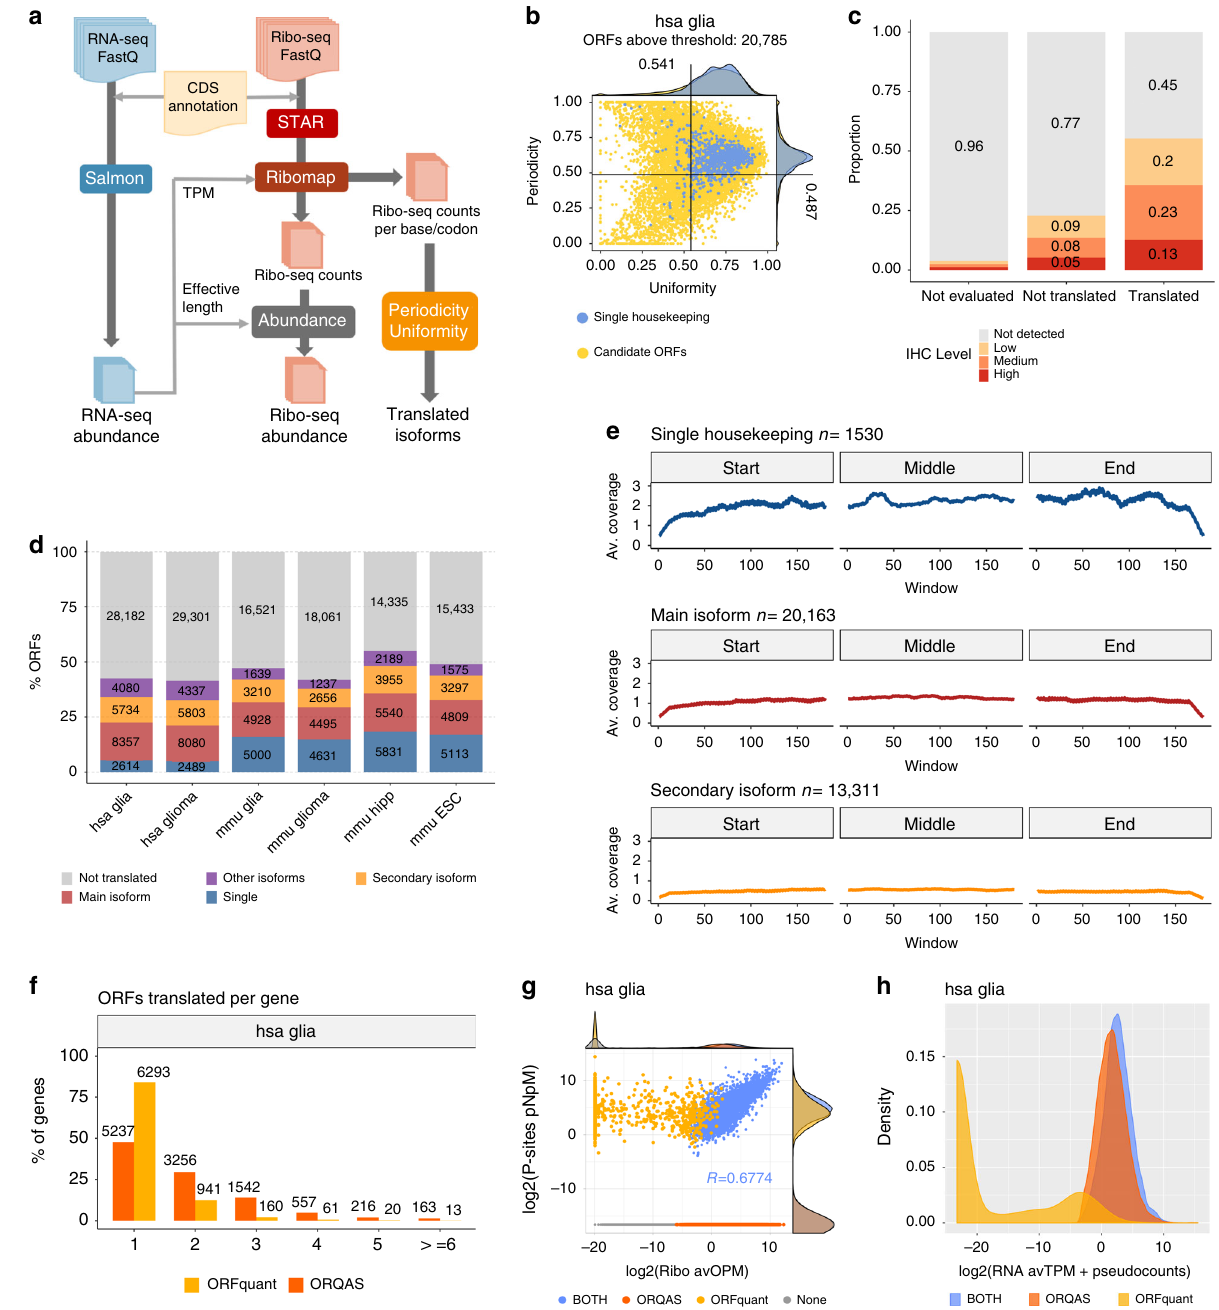
Fig. 1 Estimation of translated isoforms. a Diagram of the ORQAS pipeline. b Uniformity ( x -axis) and periodicity ( y -axis) for all tested ORFs with RNA expression TPM >0.1 and ≥ 10 Ribo-seq reads assigned (yellow) from human glia ( n = 28,427). Uniformity is the percentage of maximum entropy, and periodicity is measured in the fi rst annotated frame. In blue, single-ORF genes with protein expression in 37 tissues from the Human Protein Atlas (THPA). Other samples are shown in Supplementary Fig. 1. c ORQAS predictions in human glia for 1005 single-ORF genes. The plot shows the protein expression from immunohistochemistry (IHC) experiments in human cortex from THPA for cases without enough RNA expression (Not evaluated n = 468), cases that do not pass the fi lters of uniformity and periodicity (Not-translated n = 176), and those predicted to be translated ( n = 361). d Number of ORFs translated per sample, according to whether the ORF is encoded by a single-ORF gene (Single), the most abundant isoform according to RNA-seq (Main isoform), the second most abundant (Secondary isoform), or by any of the remaining isoforms (Other isoforms). Tested ORFs that are not-translated are depicted in gray (Not-translated). e Average density of Ribo-seq reads along ORFs in the single-ORF genes from above, in ORFs from the most abundant isoform according to RNA-seq, and in the second most abundant isoform. f Number of ORFs translated per gene in human glia (hsa glia) according to ORQAS (orange) and ORFquant (yellow) predictions. Other samples are shown in Supplementary Fig 6. g Correlation between average ORF abundance in ribosome space for human glia (hsa glia n = 53,403) in ORFs per million (OPM) by ORQAS and P sites per nucleotide per million (P sites pNpM) by ORFquant, indicating whether each ORF is predicted only by ORQAS (orange) or by ORFquant (yellow), by both (blue), or none of them (gray). Other samples are shown in Supplementary Fig 8. h Distribution of the average RNA expression in human glia (has glia n = 30,035) in TPM for ORFs predicted only by ORQAS (orange), by ORFquant (yellow) or by both (blue). Other samples are shown in Supplementary Fig.